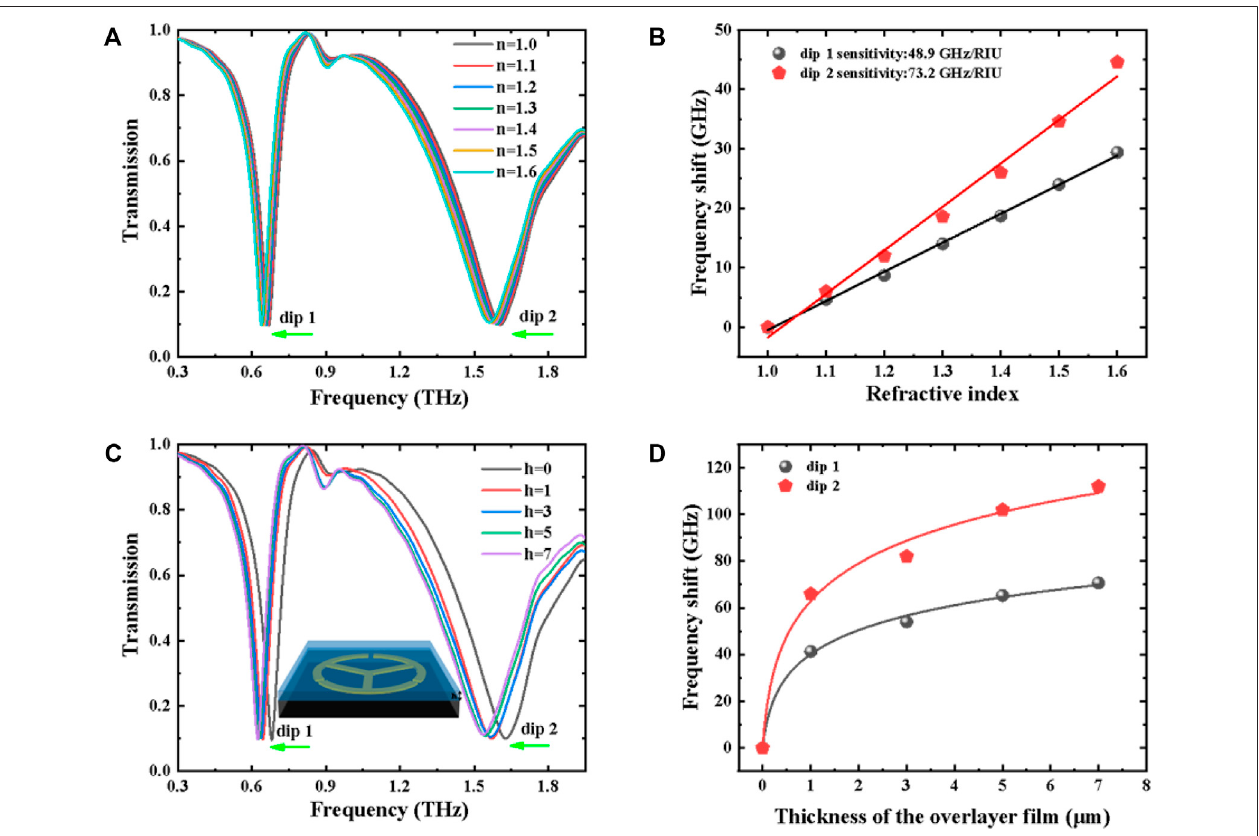
FIGURE3|(A) TransmissionspectraoftheTSRresonatorunderdifferentrefractiveindices. (B) Frequencyshift( Δ f )asafunctionofrefractiveindexfordip1anddip 2. (C) TransmissionspectraoftheTSRresonatorundervariousoverlayerthicknesses.Theinsetistheschematicdiagramofthelayeredanalytecoatingonthesurfaceof a meta-biosensor. (D) Frequency shift ( Δ f ) as a function of thickness for dip 1 and dip 2.